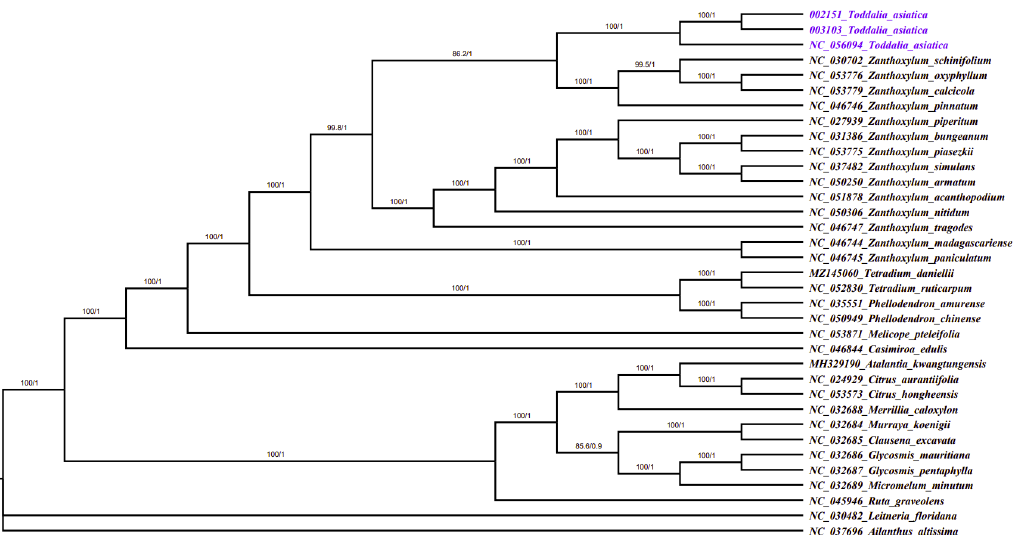
Figure 8. Phylogenetic tree construction of 35 taxa using maximum likelihood (ML) and Bayesian inference (BI) methods using 79 protein-coding genes.